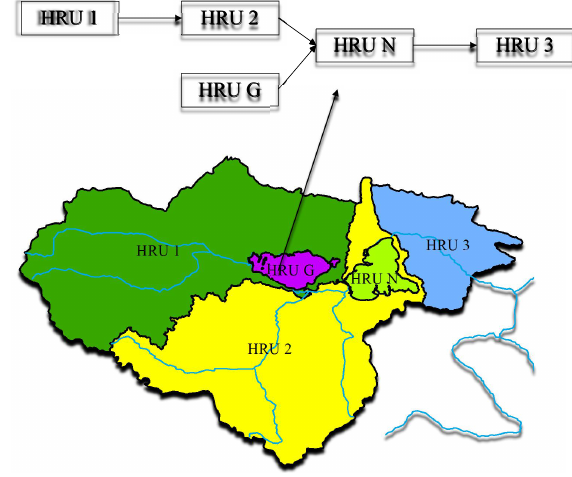
Figure 3. Connection of typical tank models in built model.